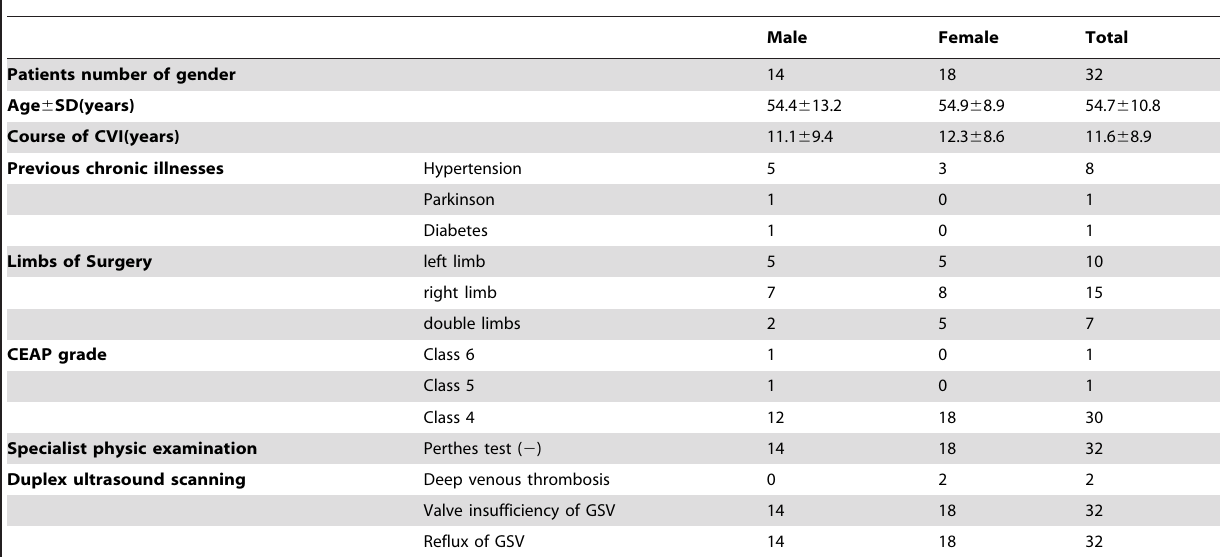
Table 1. The clinical information of 32 patients involved in the study.